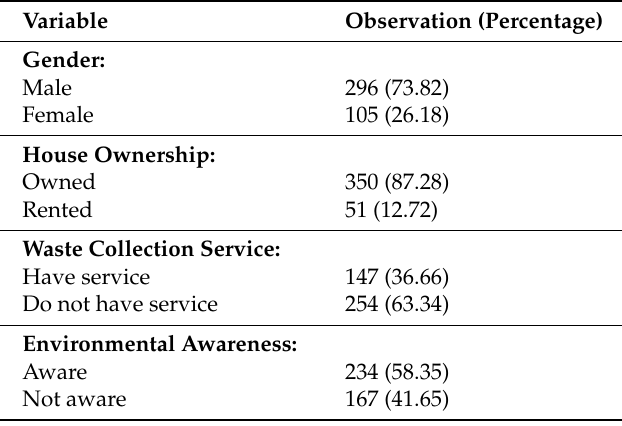
Table 4. Summary of categorical